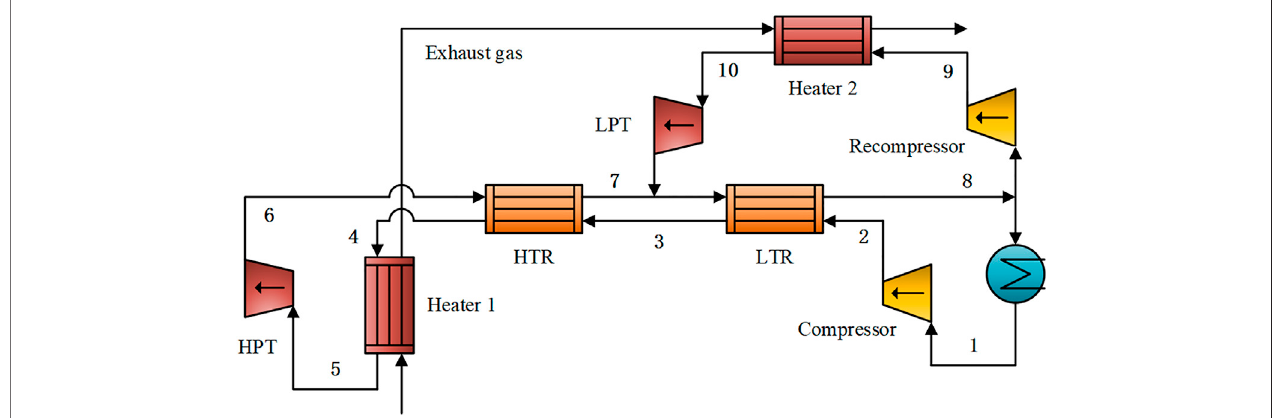
FIGURE 8 | A modi fi ed recompression sCO 2 cycle for engine waste heat recovery (adapted from (Zhang et al., 2020b)).